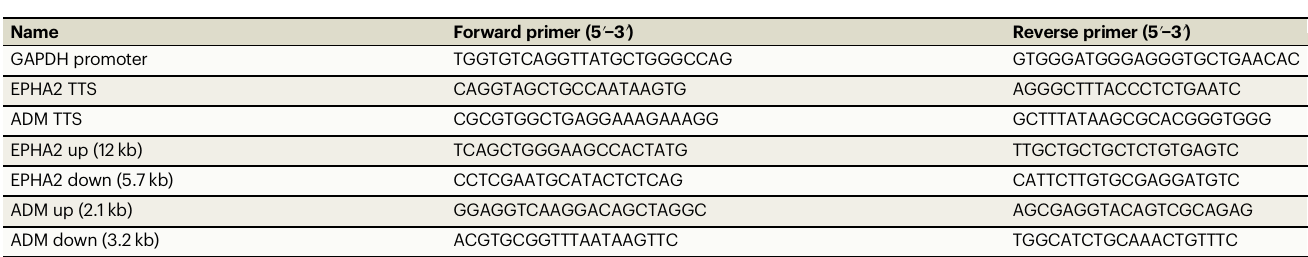
Table 3 | List of primers for